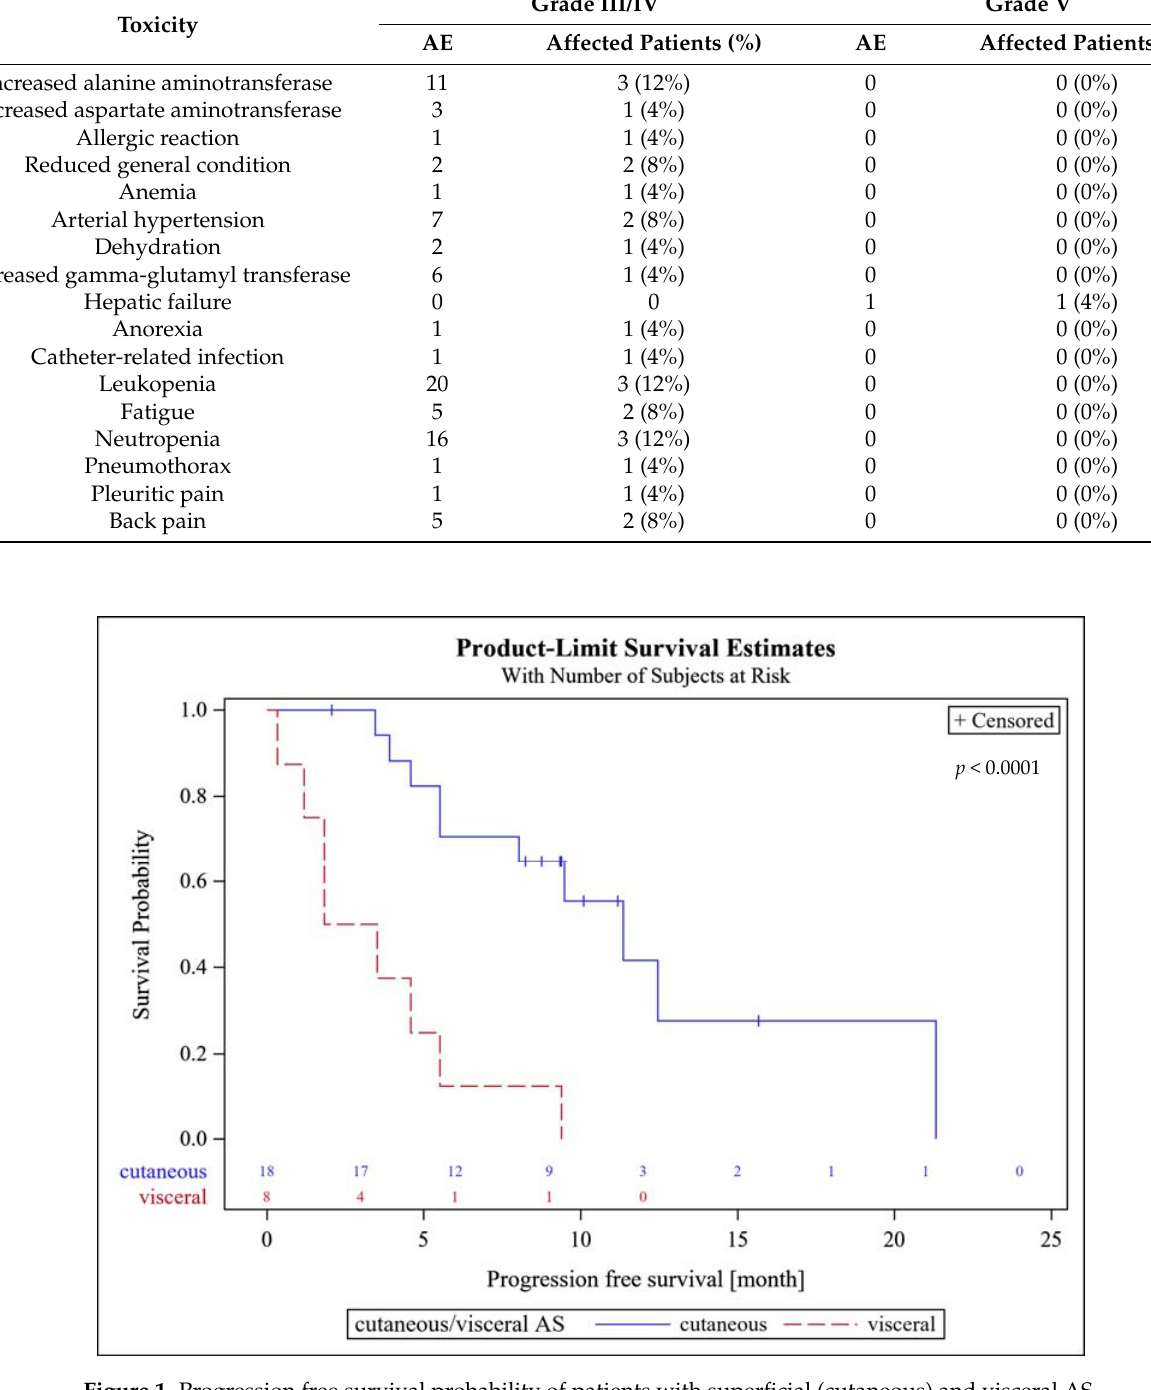
Figure 1. Progression free survival probability of patients with superficial (cutaneous) and visceral AS.